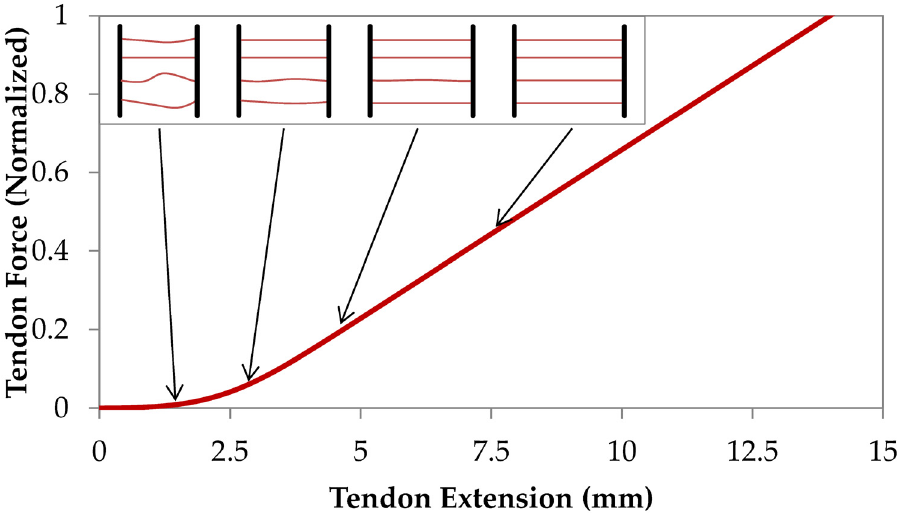
Fig 1. Discretized model of tendon. The mechanical response of tendon is constructed by aggregating the mechanical behavior of strings with different slack lengths, resulting in a non-linear tendon stress-strain